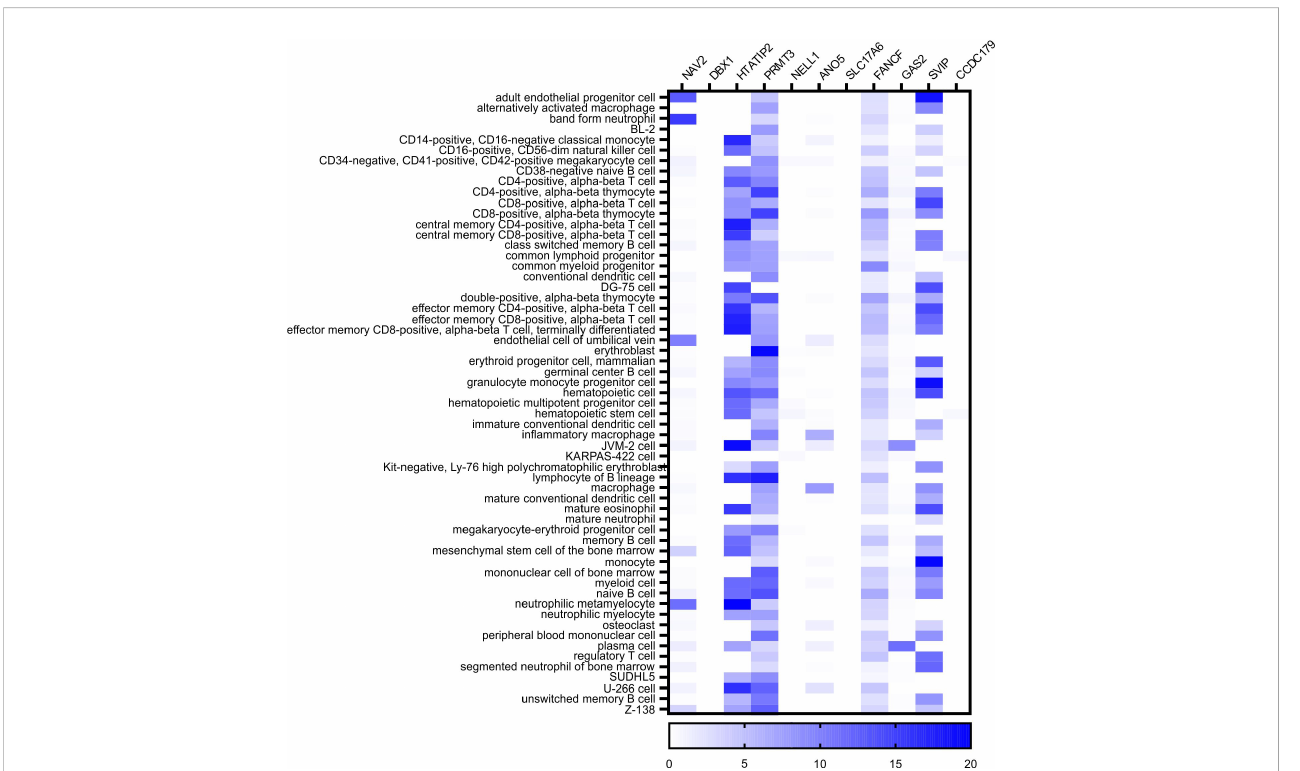
FIGURE 3 BLUEPRINT Epigenome RNA-seq data identi fi es four genes expressed in blood cells in the chromosome 11 locus. The count of reads in transcripts per million (TMP) was queried for each of the indicated cell types from the data of the BLUEPRINT Epigenome Consortium. The eleven protein-coding genes located in a 3-megabase window centered on the rs10833518 SNP are indicated with heatmap intensity of expression in each cell